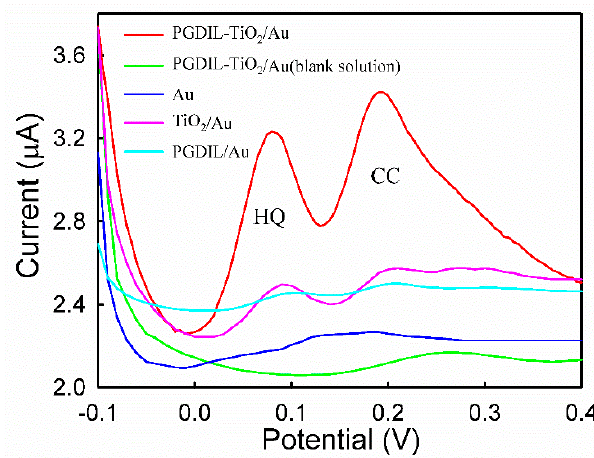
Figure 9. DPV results of 0.1 mmol/L HQ and 0.05 mol/L CC on the PGDIL–TiO 2 /Au, PGDIL/Au, TiO 2 /Au, and Au in pH = 7 PBS at a scan rate of 0.1 V/s.